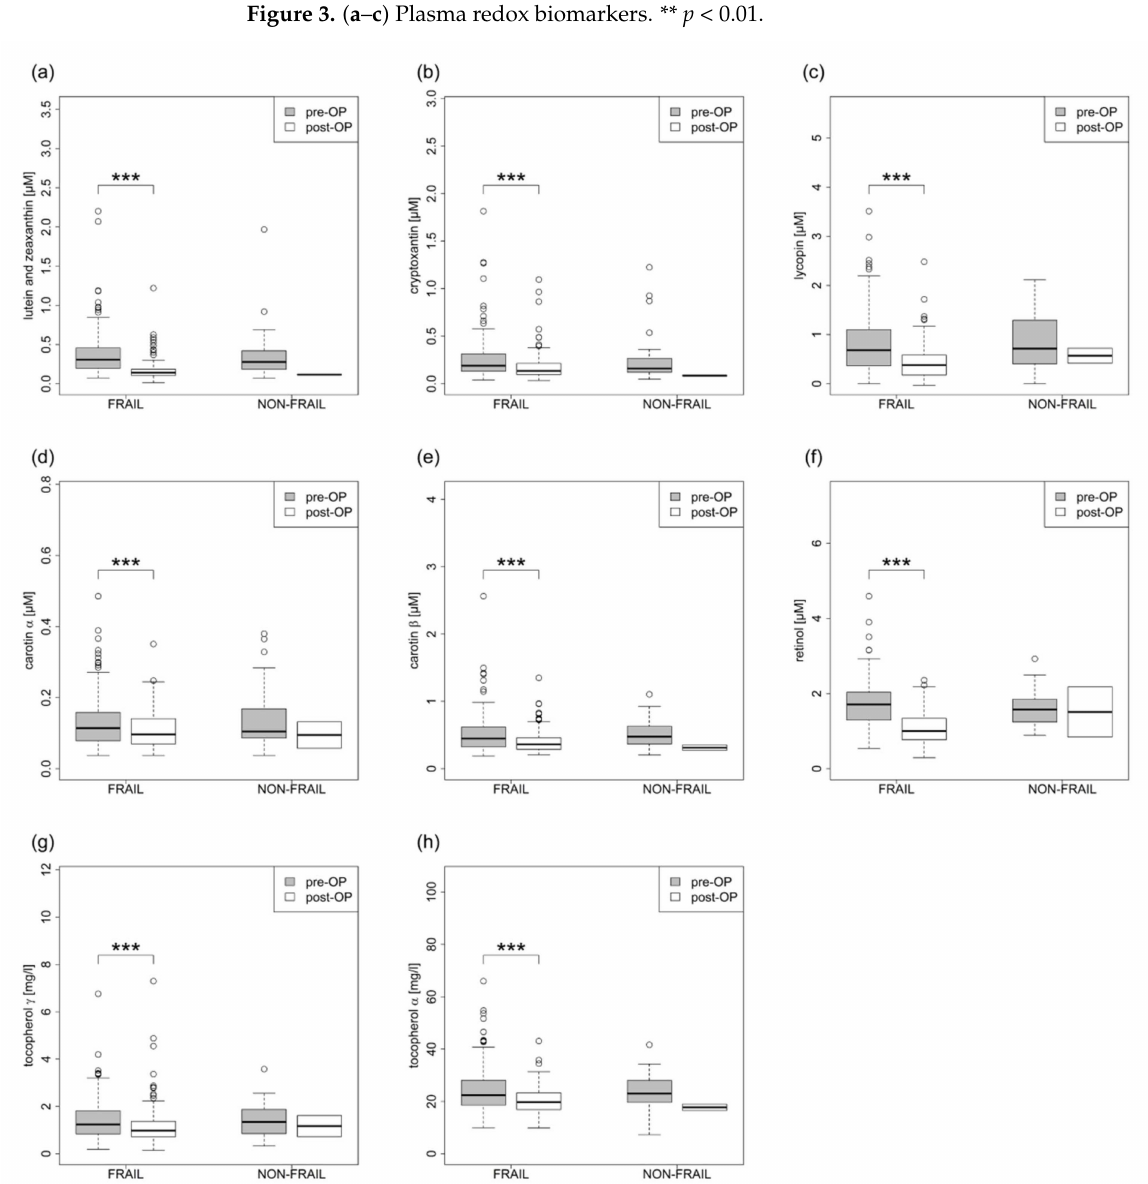
Figure 4. ( a – h ): Fat-soluble micronutrients. *** p <